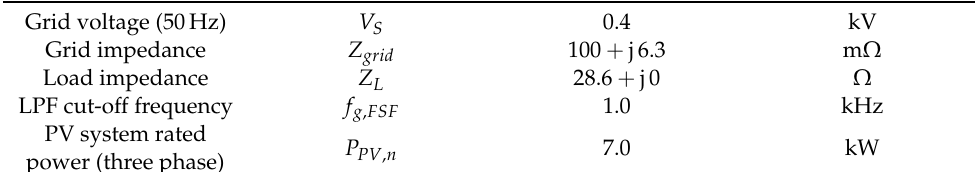
Figure 23. Power factor correction with an additional time delay Table 1. Parameter of the PHiL application